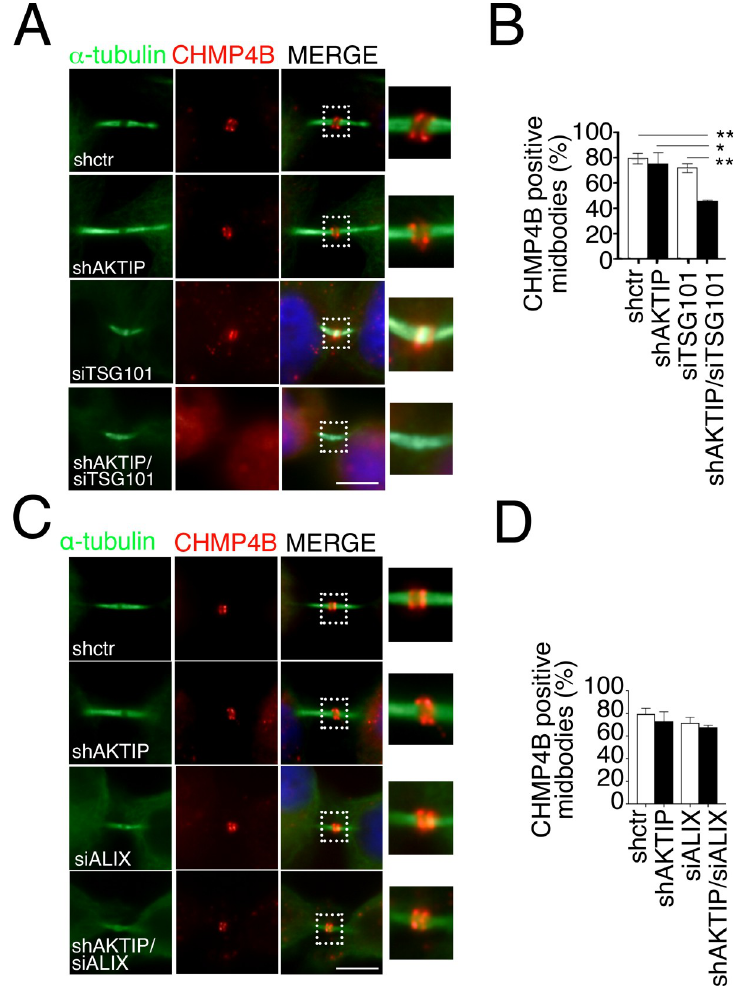
Fig 8. AKTIP cooperates with TSG101 but not with ALIX for CHMP4B recruitment. (A-B) Representative images of shctr, shAKTIP, siTSG101 and shAKTIP/siTSG101 HeLa cells stained for CHMP4B (red) and α -tubulin (green) and relative quantification. (C-D) Representative images of shctr, shAKTIP, siALIX and shAKTIP/siALIX HeLa cells stained for CHMP4B (red) and α -tubulin (green) and relative quantification. For results in (B and D) at least 100 midbodies per condition were counted. Scale bars, 5 μ